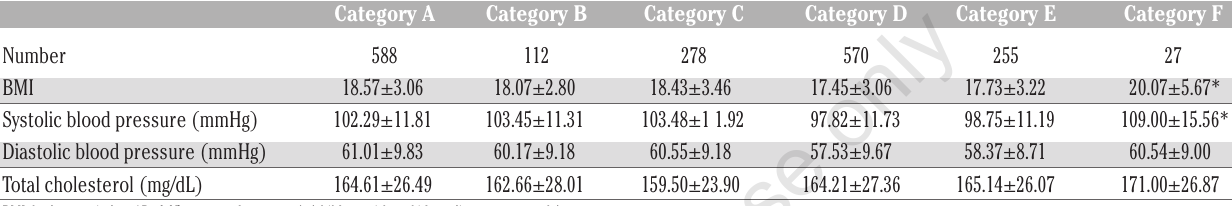
Table 2. Body mass index, blood pressure and serum cholesterol in the